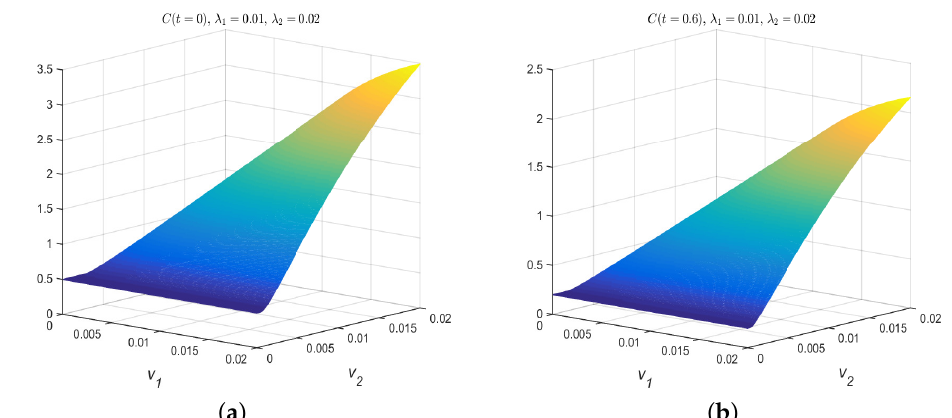
Figure 7. Time evolution of European call option price C ( t ) by fix λ , t = 0 ( a ) and t = 0.6 ( b ) in the asymmetric case.